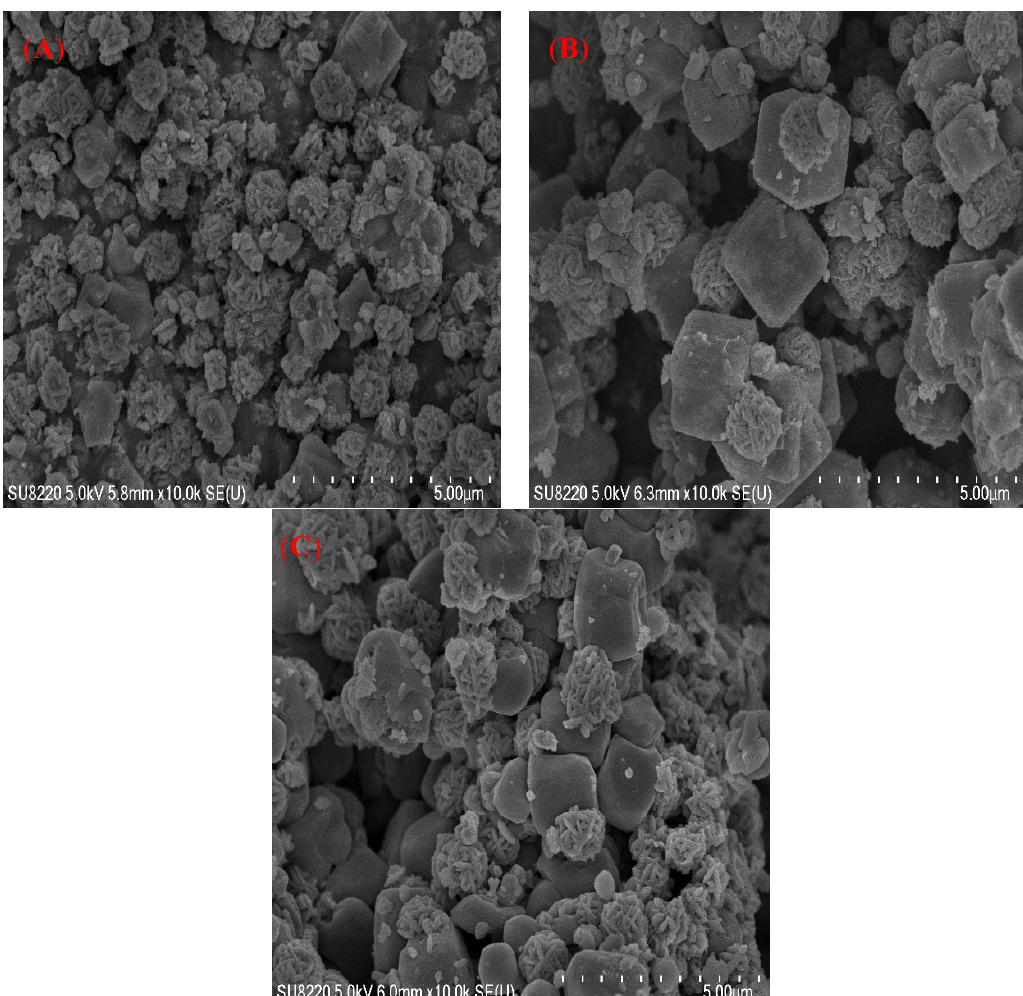
Figure 5. Scanning electron microscope (SEM) images of BFSZ synthesized at crystallization times of ( A ) 4 h ( B ) 6 h and ( C ) 8 h.